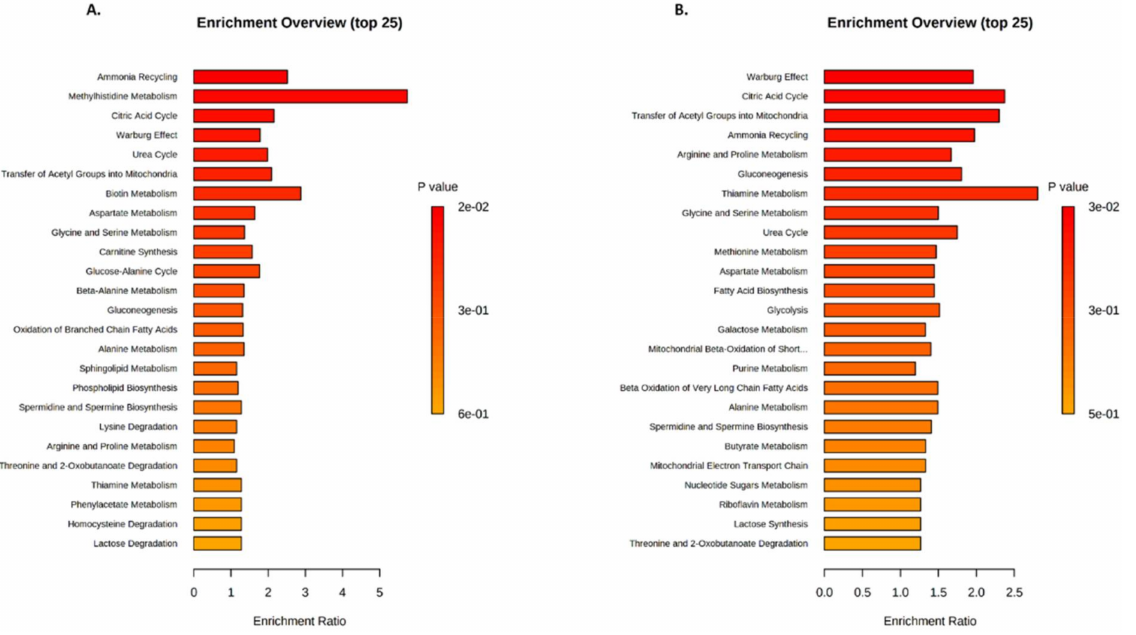
Figure 5. Metabolite Set Enrichment pathway Analysis (MSEA) in serum ( A ) and soleus ( B ). Metabo- lite set enrichment diagrams (25 top pathways) were obtained using MetaboAnalyst 5.0 on the 96 VIP found in serum and the 88 VIP found in